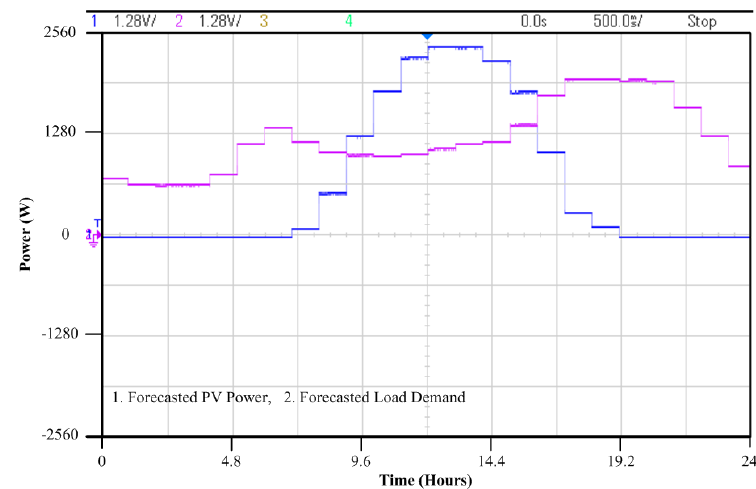
Figure 12. Forecasted PV power and load